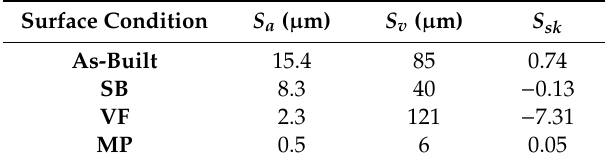
Table 3. Areal surface roughness values of the investigated alloy after the different surface finishing methods.